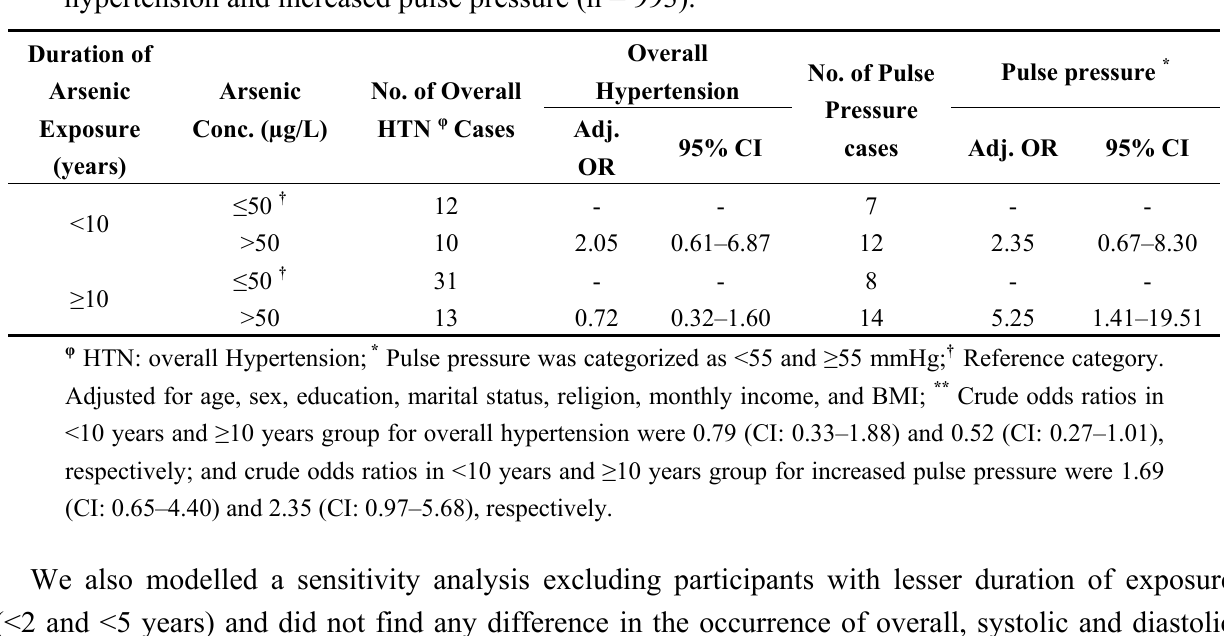
Table 4. Association of arsenic and duration of its exposure separately with overall hypertension and increased pulse pressure (n =